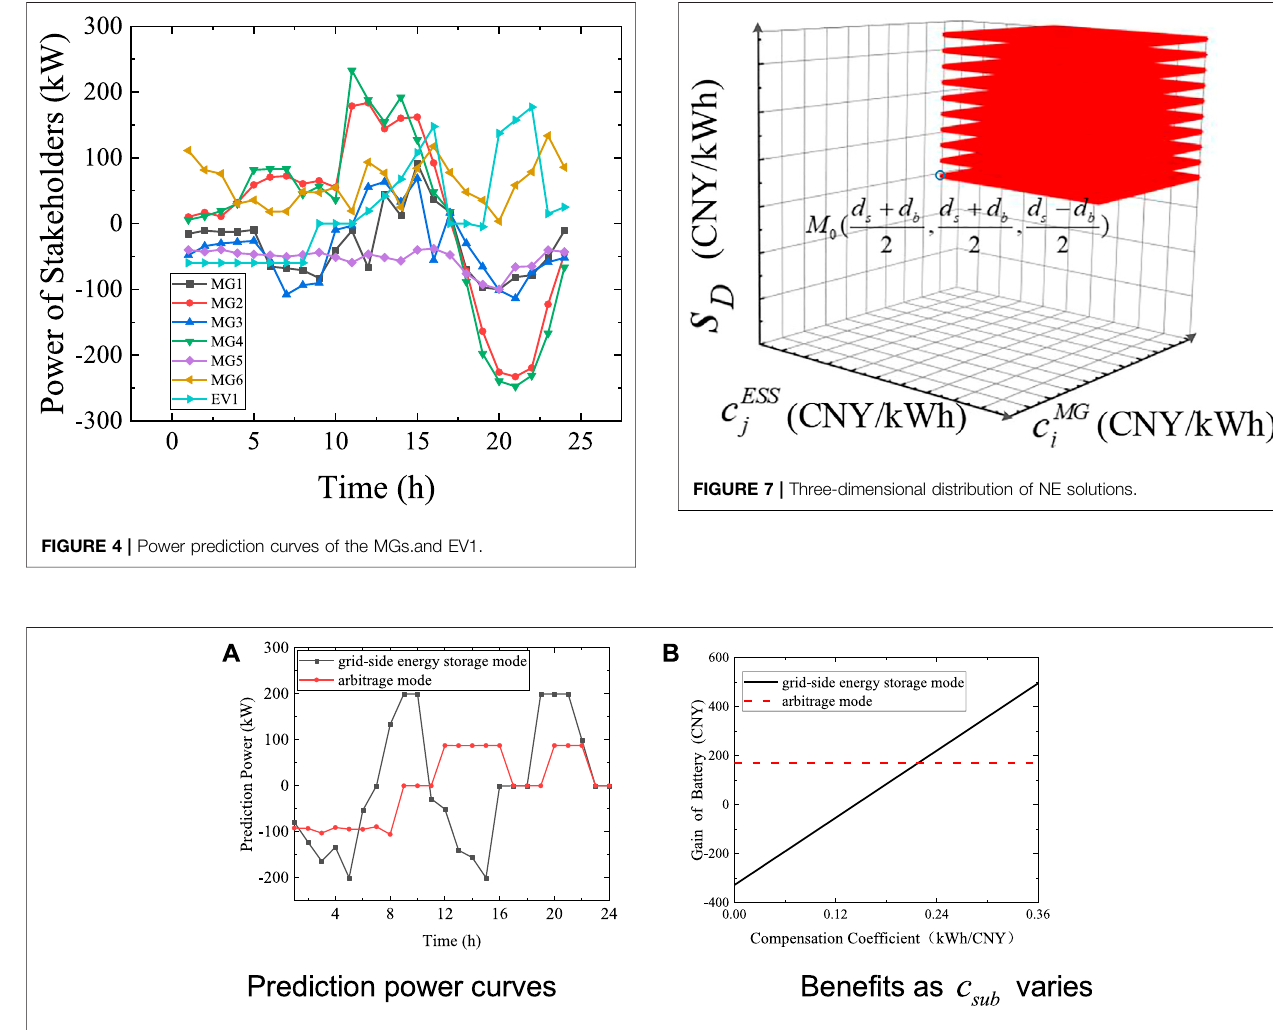
FIGURE 5 | Battery operates in different modes.